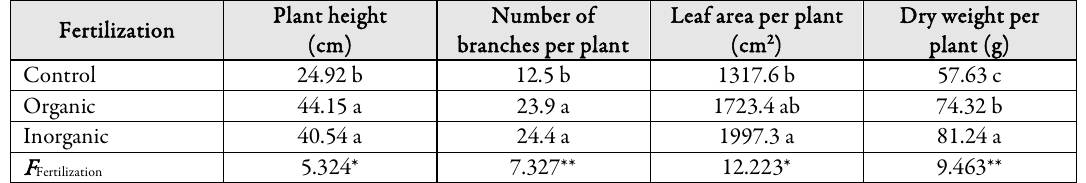
Table 2. Plant height, number of branches per plant, leaf area per plant and dry weight per plant of P. peruviana as affected by fertilization Plant height Number of Leaf area per plant Dry weight per Fertilization (cm) branches per plant (cm 2 ) plant (g) Control 24.92 b 12.5 b 1317.6 b 57.63 c Organic 44.15 a 23.9 a 1723.4 ab 74.32 b Inorganic 40.54 a 24.4 a 1997.3 a F